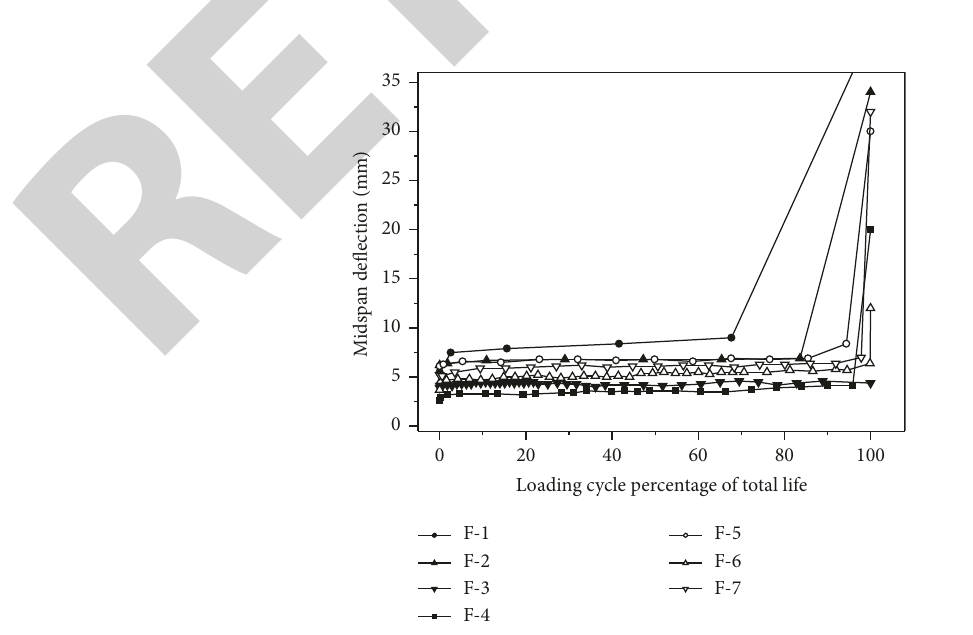
Figure 8: Overall evolution law of test girder